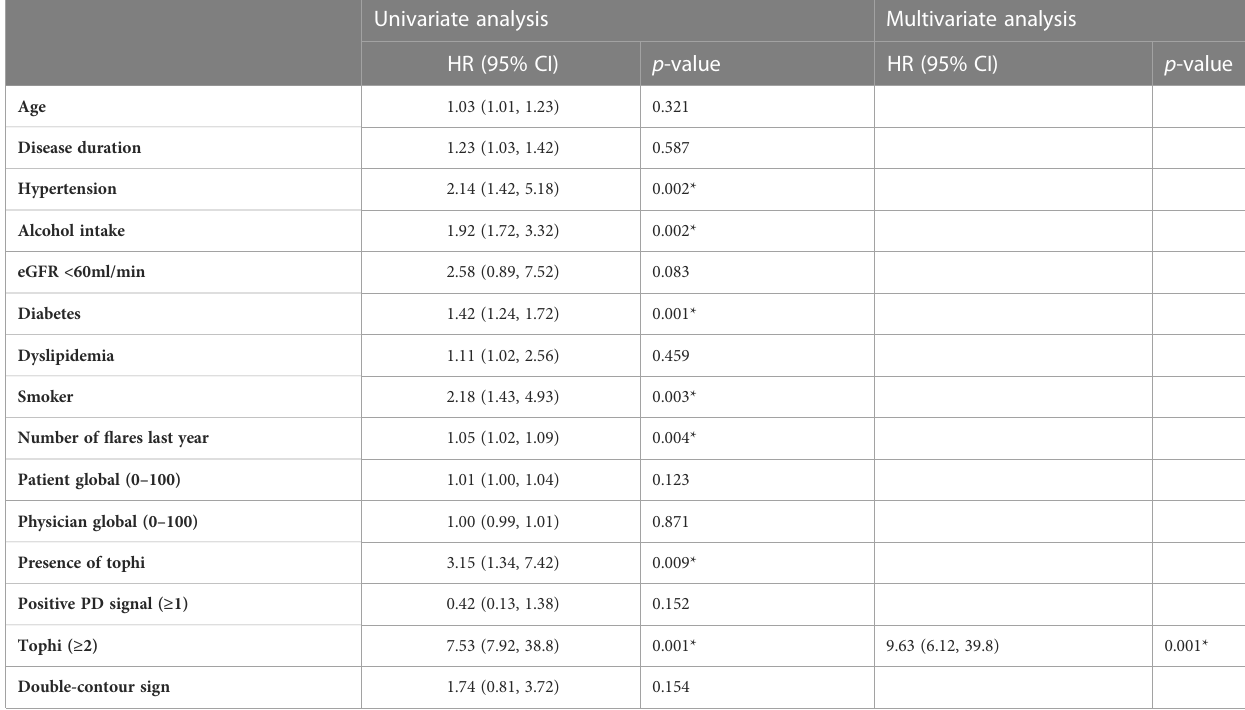
arteries are especially useful for detecting subclinical tophi and the association of the presence of at least two tophi and carotid subclinical arteriosclerosis and signi fi cantly improving plaque on ultrasound with MACE in addition to traditional cardiovascular risk assessment in gout patients. It supports the cardiovascular risk factors in a long-term follow-up cohort of need to use additional validated tools like carotid US to improve CV gout patients. Ultrasound evaluations in joints and carotid TABLE 3 Univariate and multivariate Cox regression analyses for parameters as predictors for MACE ( n = 240). Univariate analysis Multivariate